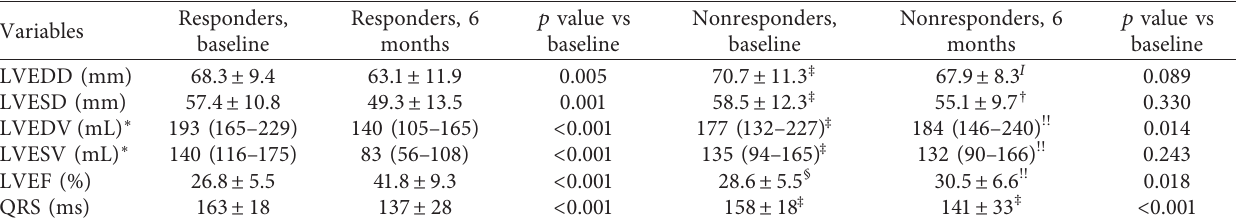
Table 3: Differences in echocardiographic variables and QRS duration between baseline and the 6-month follow-up and between re- sponders and